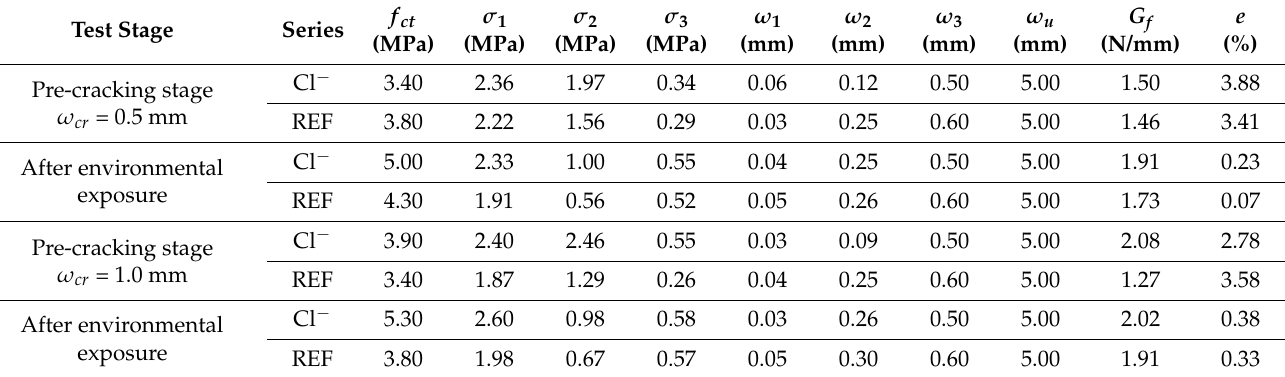
Table 9. The graphical representation of these σ − ω diagrams is presented in Figure 17a–d. Table 9. Parameters of the σ − ω relationship obtained by inverse analysis of the